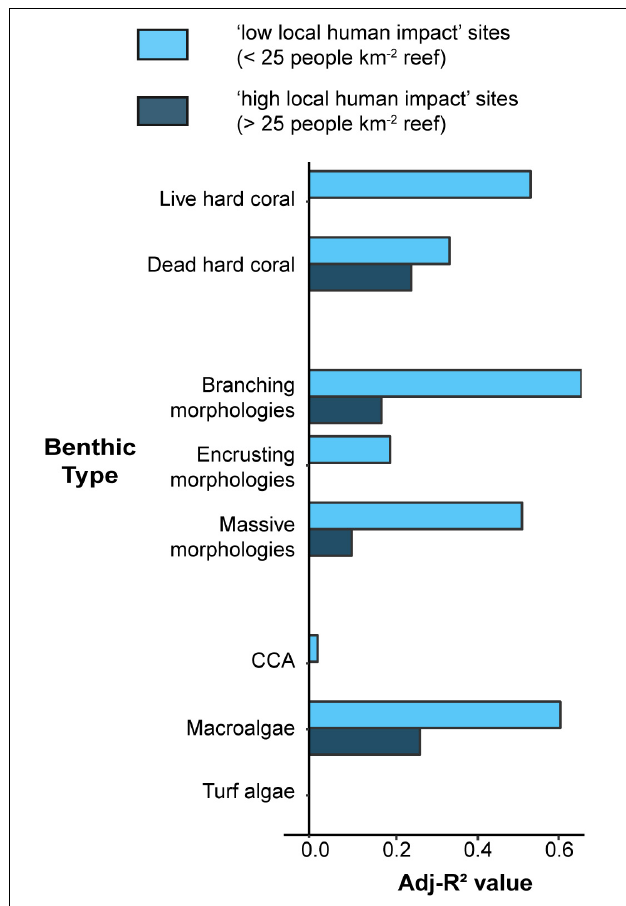
FIGURE 2 | Explanatory power (Adj- R 2 ) of the spatio-physical model (including the predictors storm exposure, reef depth, latitude, and island relief) in predicting individual benthic responses (live hard coral, dead hard coral, the proportion of branching, encrusting, and massive morphologies, and cover of algal groups CCA, macroalgae, and turf algae). Bars are absent where the Adj- R 2 value =